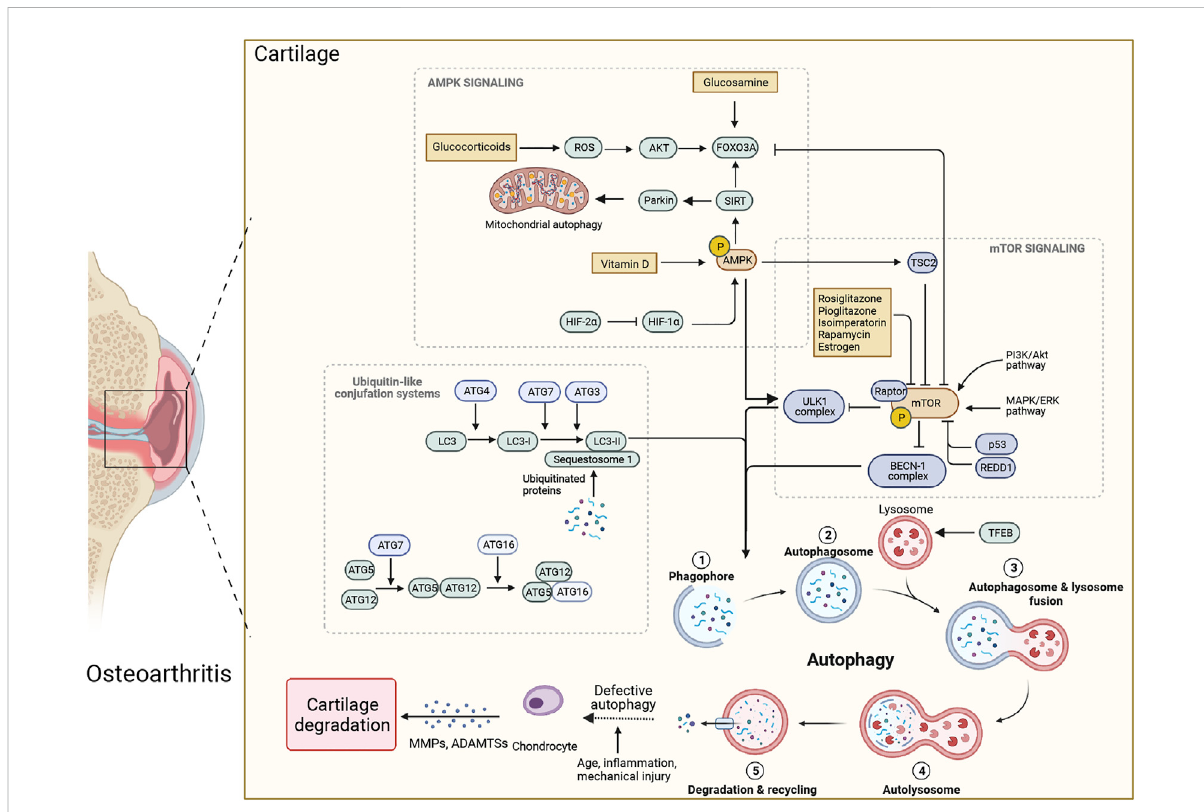
FIGURE 1 Therapeutic modulators of autophagy and associated mechanisms in osteoarthritis (OA). Autophagy is a multistep process that includes: ① phagophore formation; ② expansion elongation of phagophores to produce autophagosome; ③ autophagosomes fuse with endosomes and lysosomes; ④ autolysosome formation; ⑤ degradation of sequestered cargo in the autolysosome and recycling. Defective autophagy can lead to extracellular matrix degradation, resulting in OA. The mammalian target of rapamycin (mTOR) and AMP-activated kinase (AMPK) are the main regulators ofchondrocyteautophagyinOA,withmTORacting asaninhibitorandAMPKasanactivator.TheAMPKcouldphosphorylateandactivate the sirtuin1 (SIRT1) and forkhead box class O 3a (FOXO3a), triggering autophagic fl ux through unc-51 like autophagy activating kinase 1 (ULK1), then suppressing mTOR. ULK1-mediated phosphorylation of AMPK constitutes a negative regulatory feedback loop. The mTOR can inhibit ULK1 and beclin-1 complexes, causing activation ofautophagy. In addition, the transition fromphagophore to autophagosome dependson theactivityof two ubiquitin-like conjugation systems, the ATG5 – ATG12 and LC3 system. The ubiquitin-like protein of ATG12 attaches to ATG5 with a covalent bond, andcombineswithATG16toelongatethepre-autophagosomalmembrane.LC3-IIistransformedfromLC3-Ithroughthelipidationoftheubiquitin- like reaction and binds to autophagic vesicles. Glucosamine can promote autophagy in cartilage through activating the dephosphorylation of FOXO3a.Incontrast,glucocorticoidscanstimulateFOXO3aandactivateautophagythroughahigherlevelofreactiveoxygenspecies.VitaminDcan alleviate OA through AMPK-mTOR pathway. The rosiglitazone, pioglitazone, rapamycin, estrogen and isoimperatorin can inhibit mTOR activity, making them good candidates for potential therapies of